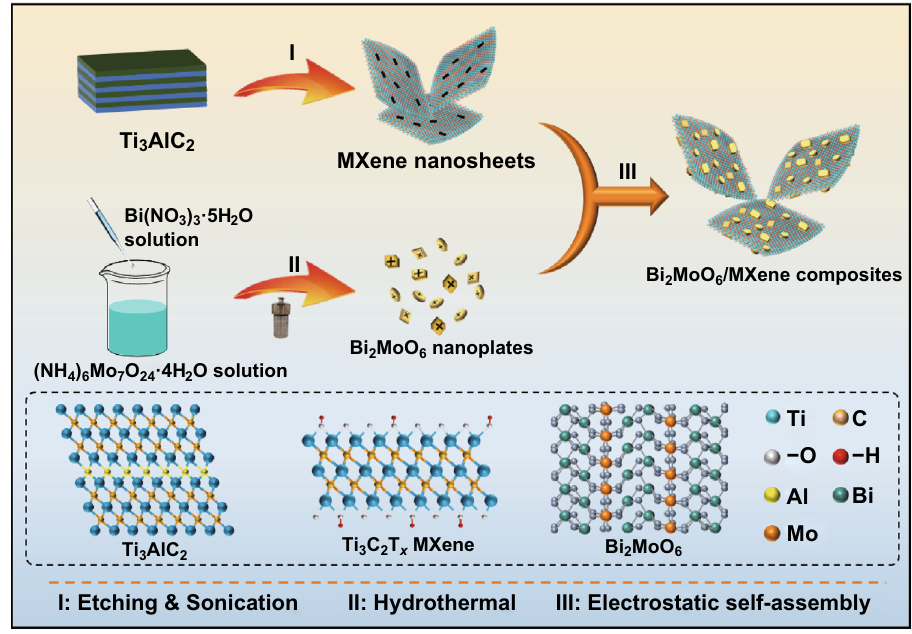
Fig. 1 Schematic diagram for the simple electrostatic self‑assembly of positive‑charged Bi 2 MoO 6 nanoplates on the negative‑charged MXene